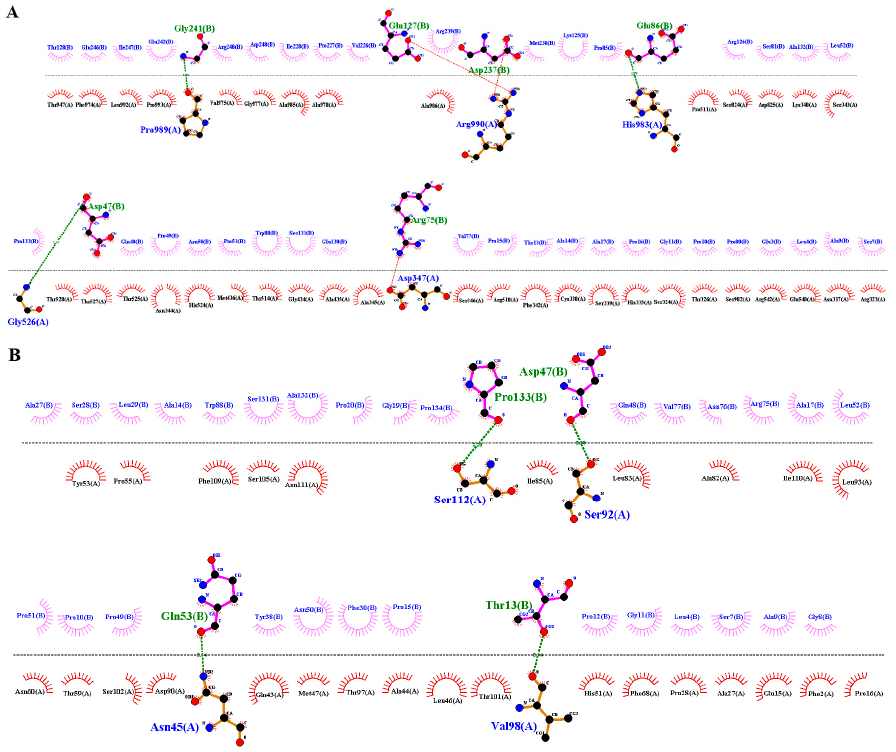
Figure 8. Interactions of the wildtype and mutant GLI1 with their close interactor SUFU. ( A ) Five residues (chain A) of wild type GLI1 interacting with six residues (chain B) of SUFU via three hydrogen bonds and three salt bridges. ( B ) Four residues (chain A) of mutant GLI1 interacting with four residues (chain B) of SUFU via four hydrogen